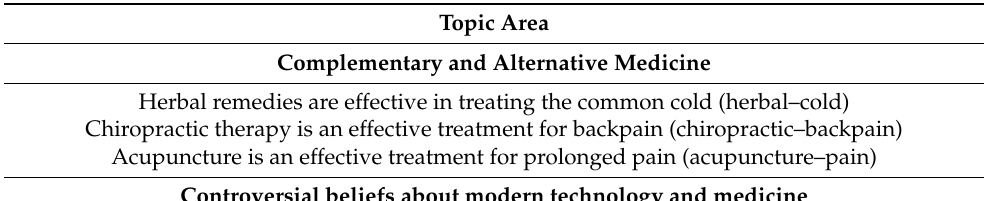
Table 1. Target health beliefs included in this